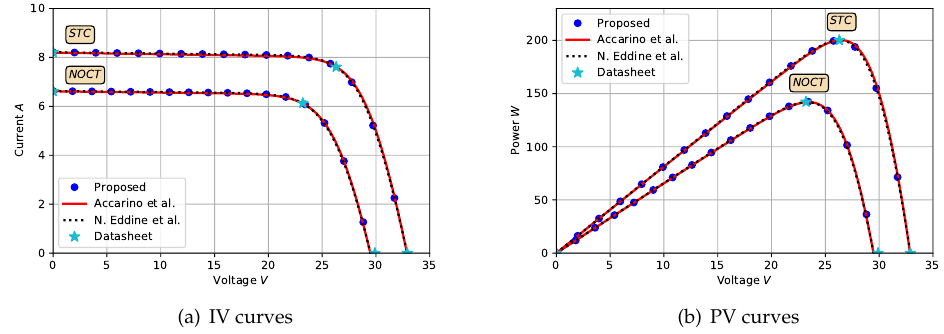
Figure 15. IV and PV curves traced for the highest-performance single-diode models shown in Table 3. The performance for the standard test condition STC and the normalized operating cell temperature NOCT are